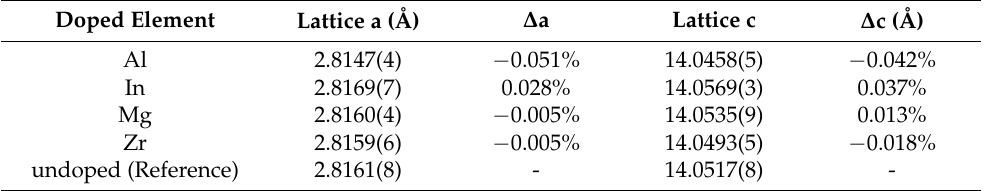
Table 2. Calculated lattice parameters of doped LiCoO 2 , and their variation compared to the un- doped LiCoO 2 .